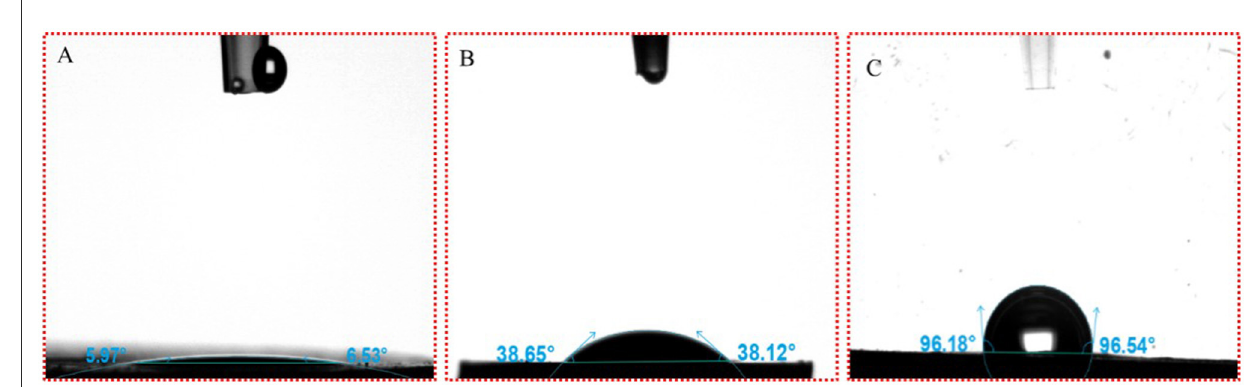
FIGURE13 Three-phase antennae ( θ ) images of water droplets on β -CD and GO/ β -CD ICs. (A, B) β -CD and GO/ β -CD ICs at the water–air interface; (C) was for water–oil interface of β